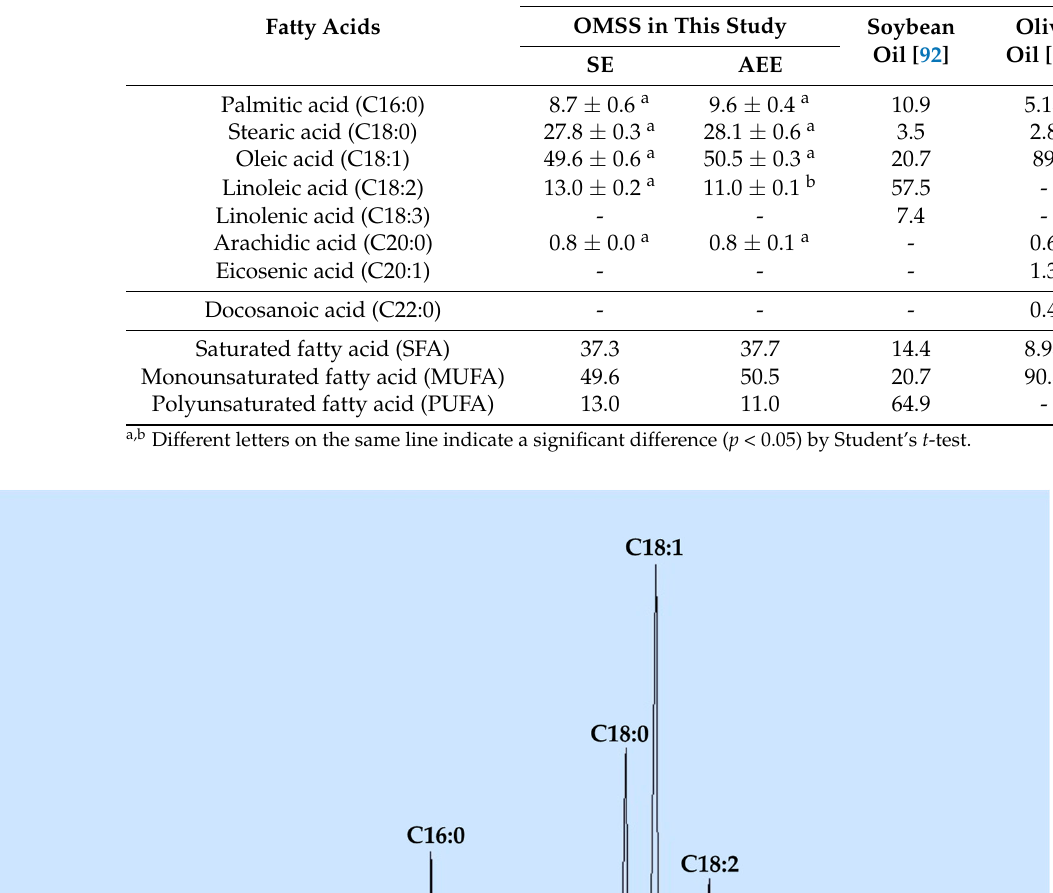
Table 4. Fatty acid composition of OMSS obtained by aqueous enzymatic extraction (AEE) and sol- vent extraction (SE), in comparison with soybean and olive oils.